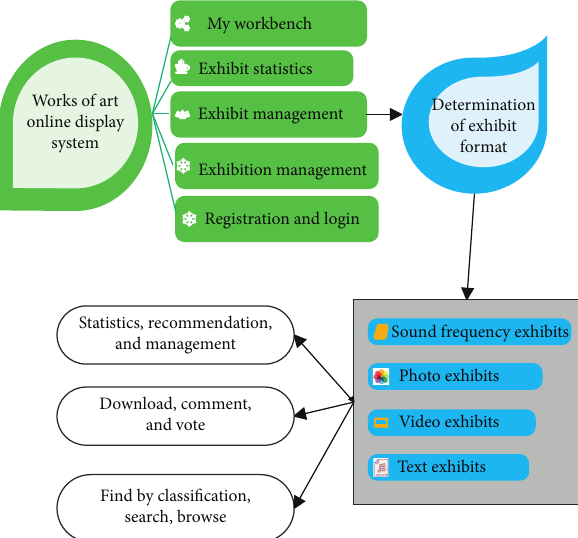
Figure 8: Art online design system based on digital simulation technology.